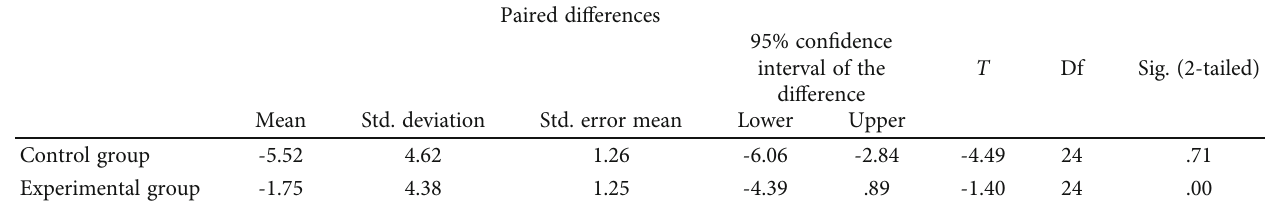
Table 6: Paired sample t -test (pre- and posttests of both groups).